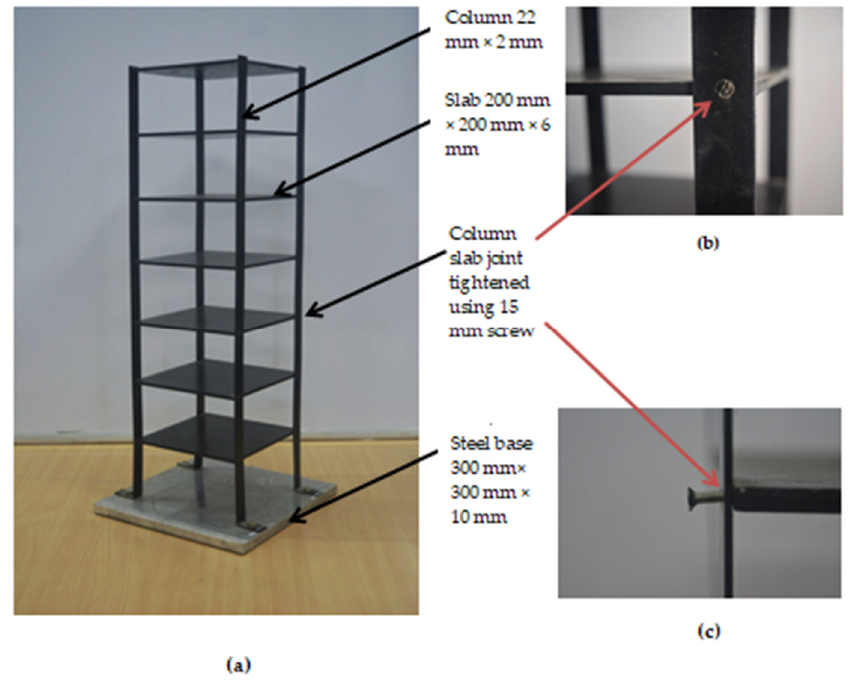
Figure 2. Fabricated scaled superstructure model: ( a ) overall view, ( b , c ) joint details.